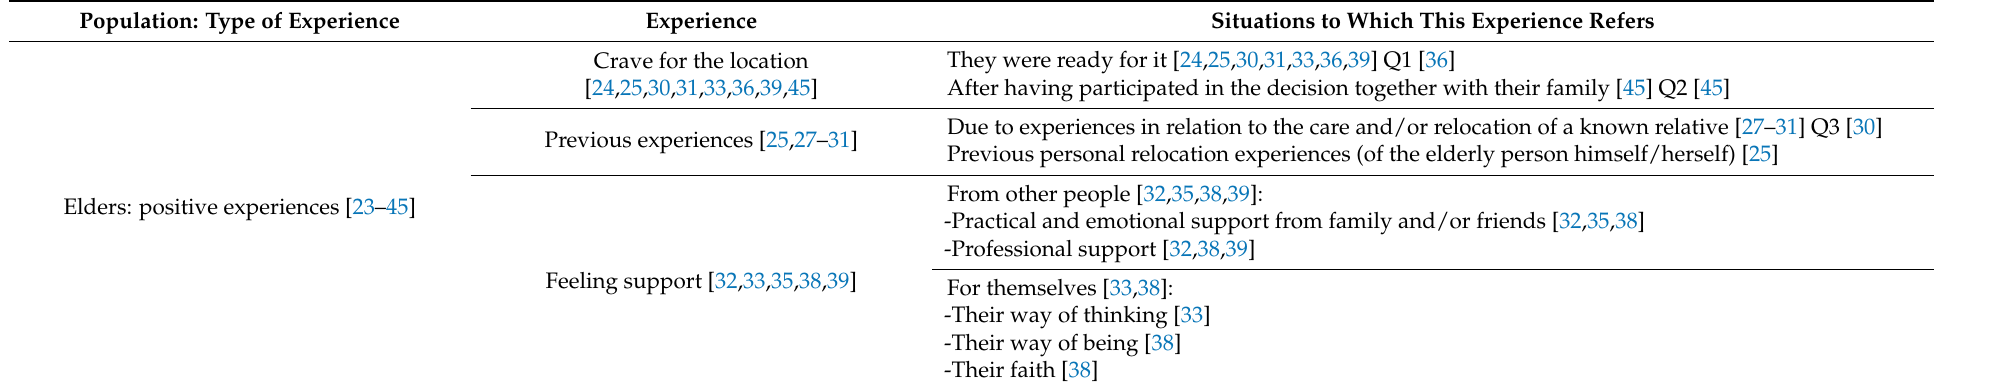
Table 1. Relevant positive experiences of the elderly a